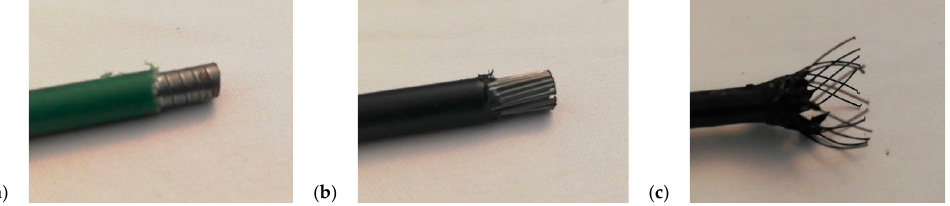
Figure 6. Spiral types: laminated spiral without inner tube ( a ), push-pull spiral ( b ), and braided spiral ( c ).